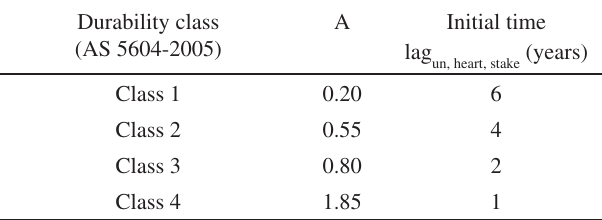
Table 3. Statistics of the climatologic data.